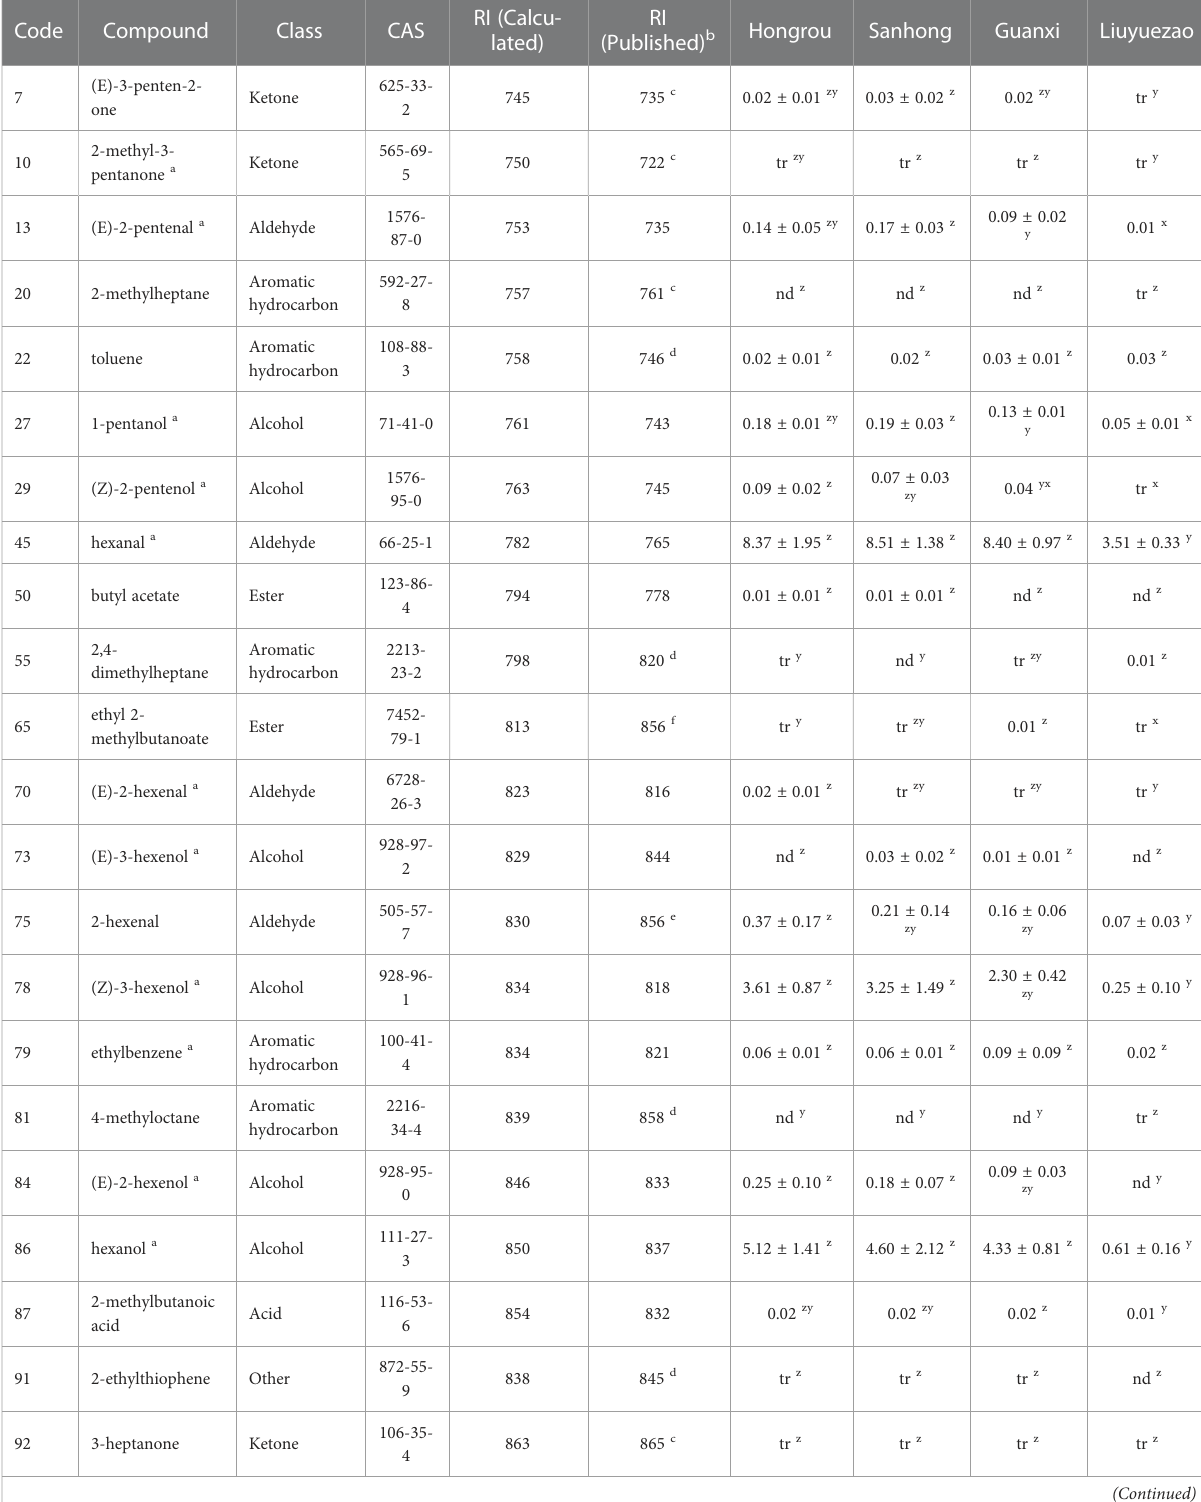
TABLE 3 Aroma volatiles in pulp samples among the four pummelo